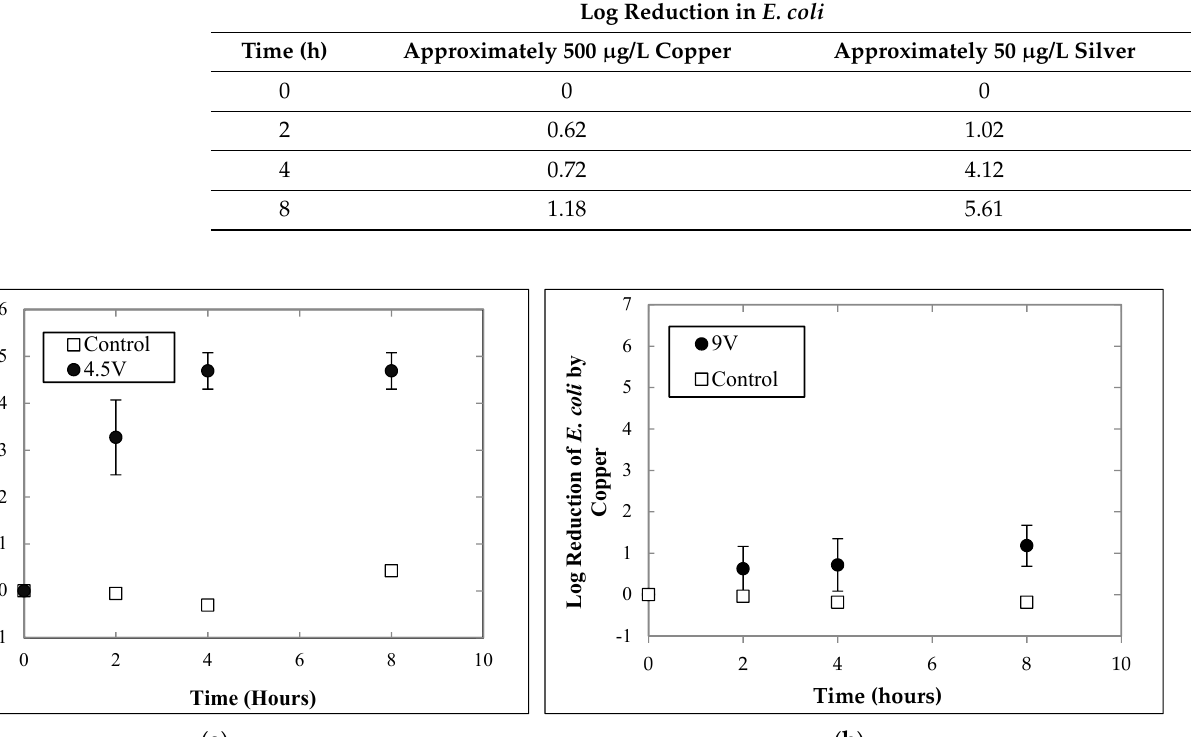
Log Reduction in E. coli Table 2. Log reduction in E. coli bacteria by electrolytically generated copper and silver.